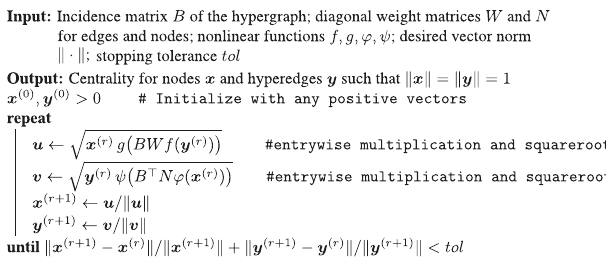
Algorithm 1 . Nonlinear Power Method for hypergraph